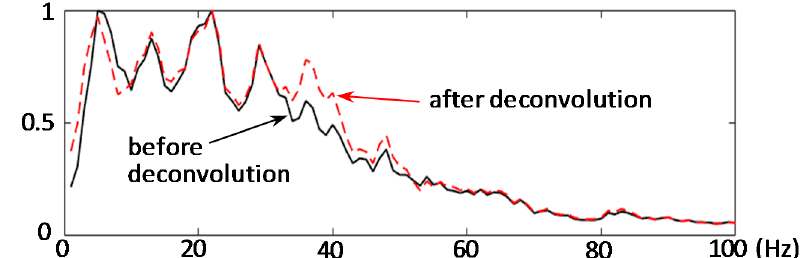
Figure 4. An example of frequency distortion by deconvolution. The black solid shows spectrum before deconvolution, whereas the red broken line is that after deconvolution. The frequency components of 30–50 Hz are raised by the deconvolution. Those spectrums were calculated in a time window 2–3 s at SP1500 of KR102.